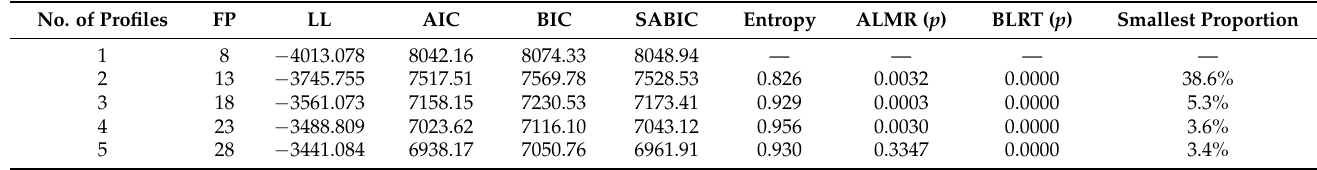
Table 2. Fit indices for the compared mixture